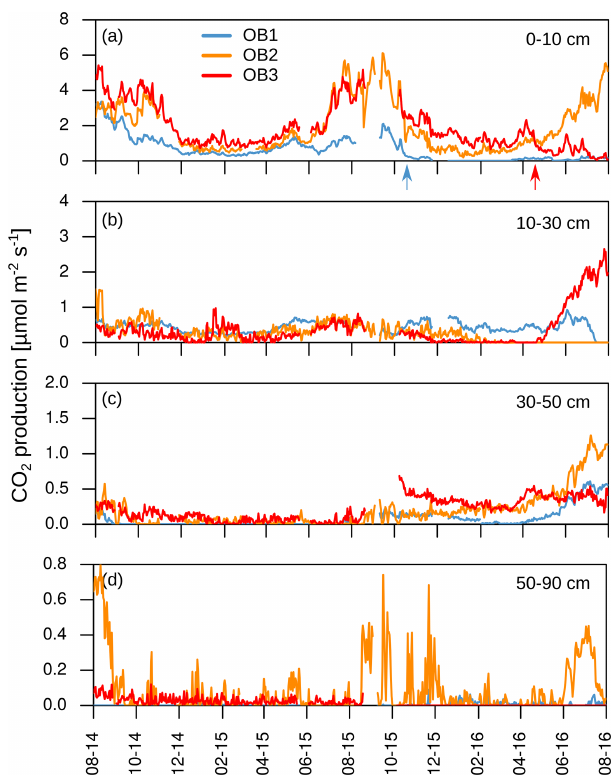
Figure 5. (a–d) Daily mean CO 2 production in each soil layer. Ar- rows indicate disturbances due to bioturbation of voles close to the CO 2 sensors at 10cm depth (OB1 and OB3), which created macro- pores and changed diffusivity.